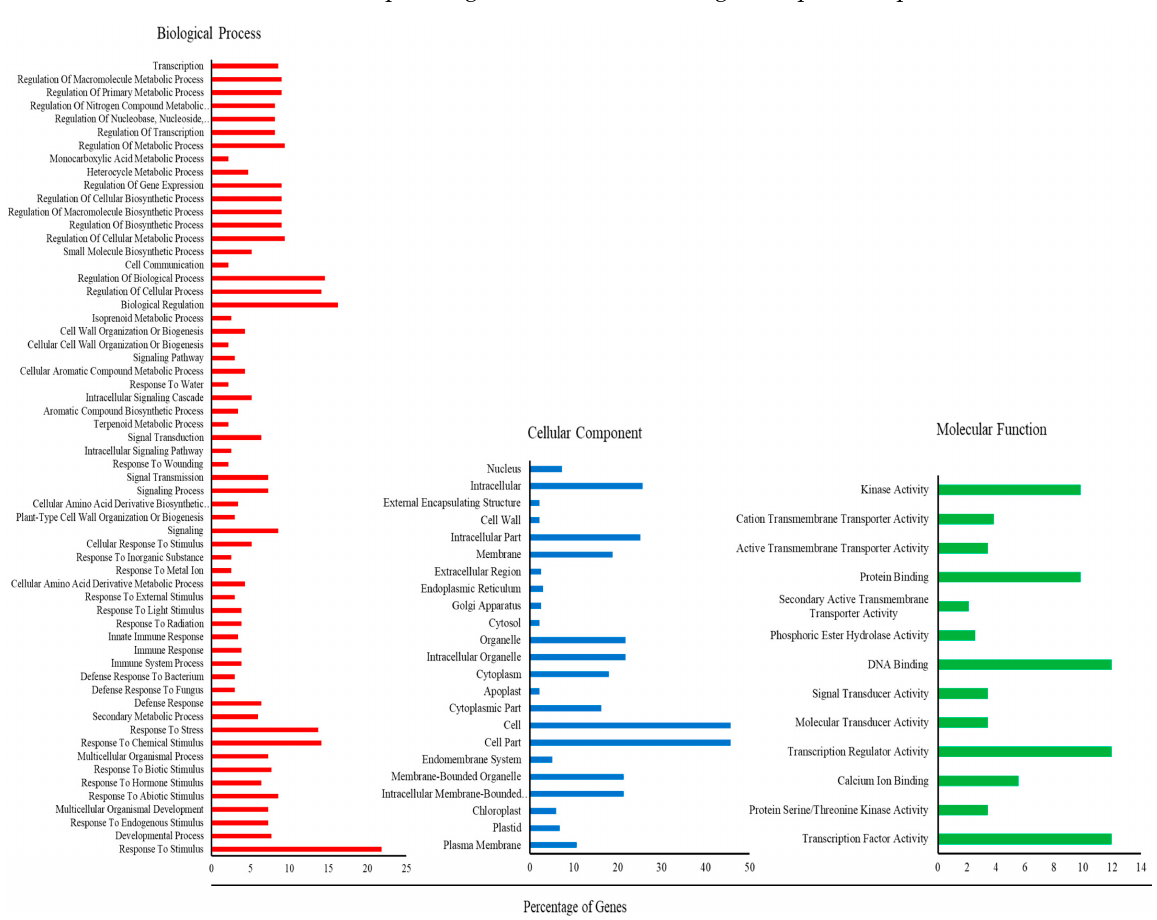
Figure 3. GO enrichment analysis of significantly differentially expressed genes.